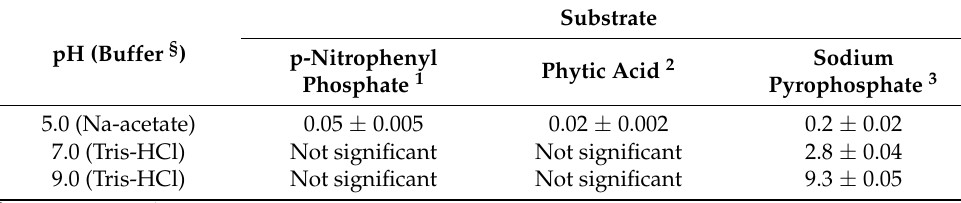
Table 1. Phosphatase, phytase, and pyrophosphatase activities of r Eh HAPp49.